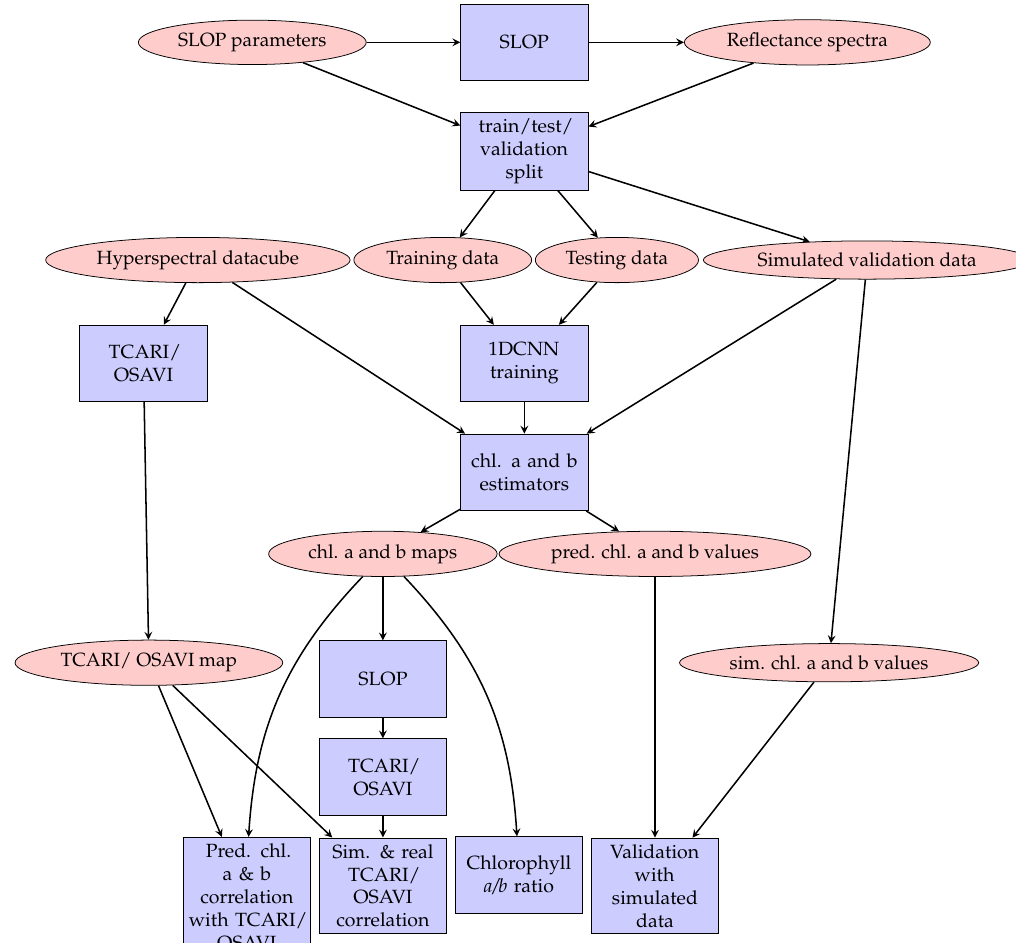
Figure 4. Flow chart of the research methodology. Ovals represent data and boxes represent